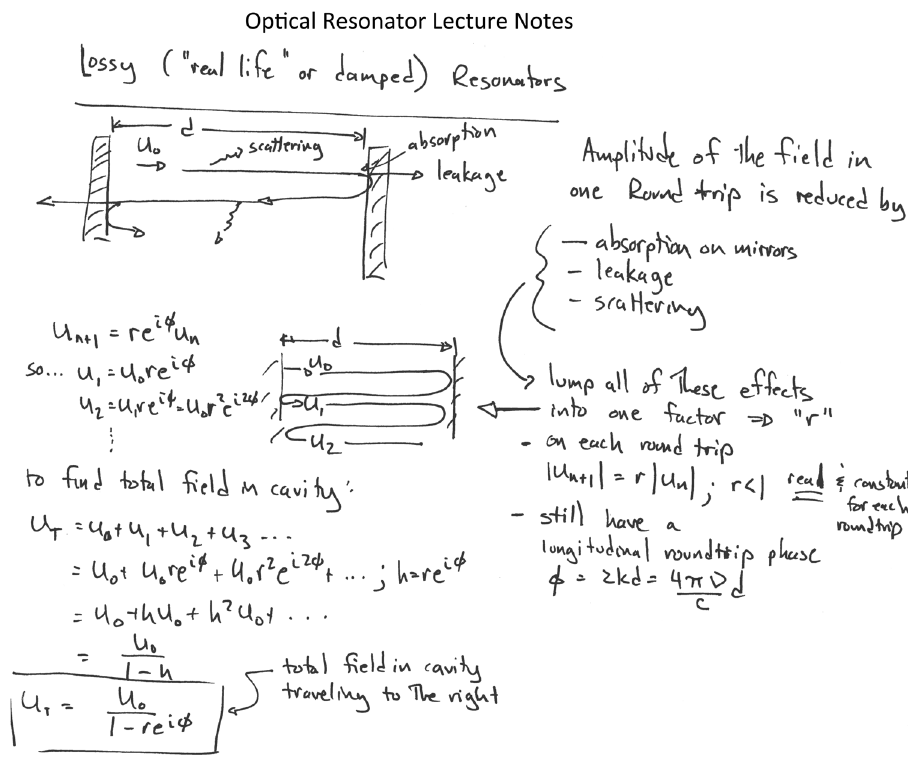
2.FIG. 2. An in-class derivation for the field inside an optical